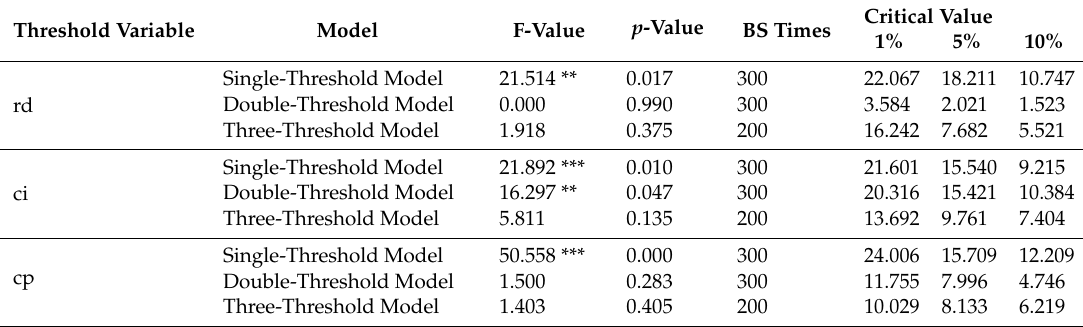
Table 9. Threshold e ff ect test results for stock market value and carbon emissions. Threshold